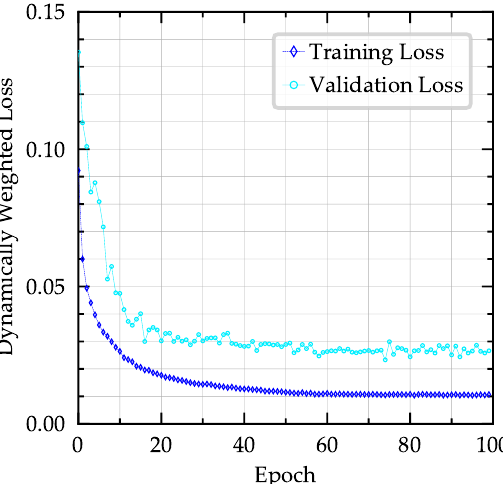
Figure 6. Dynamically weighted loss curve for Model A. The validation loss is calculated at the end of every epoch. Note that for this model, the lowest validation loss was achieved at Epoch